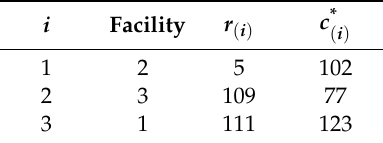
Table 7. Required data for deriving the